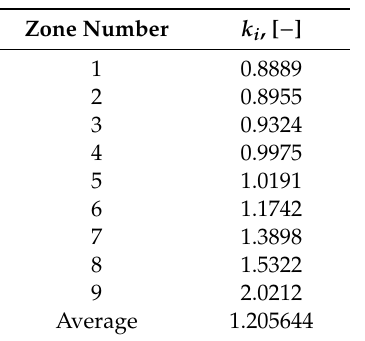
Table 4. Values of segregation ratios calculated for individual zones